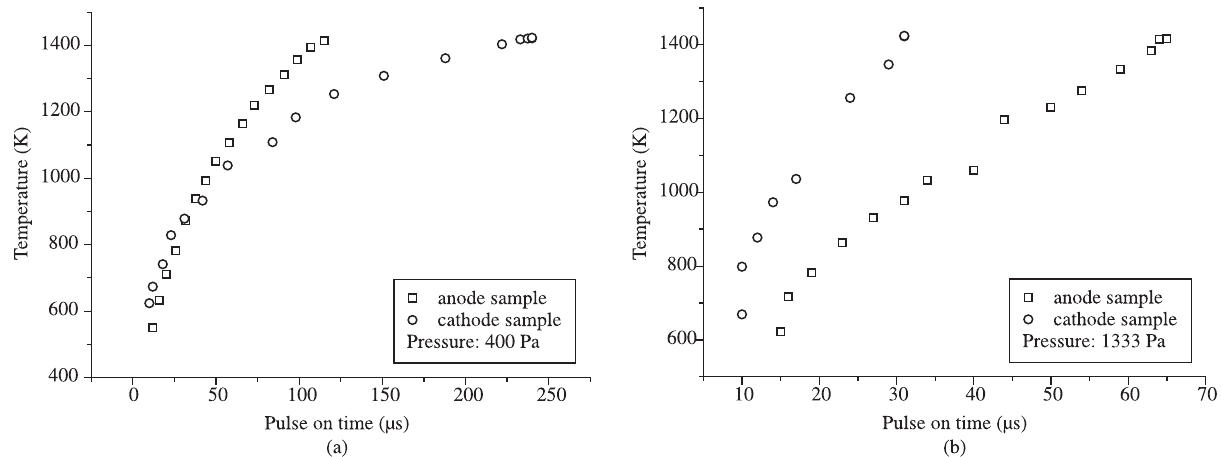
Figure 5. Evolution of temperature during heating of the sample for the settings “sample on the anode” and “sample on the cathode” for discharge with (a) 400 Pa and (b) 1333 Pa.